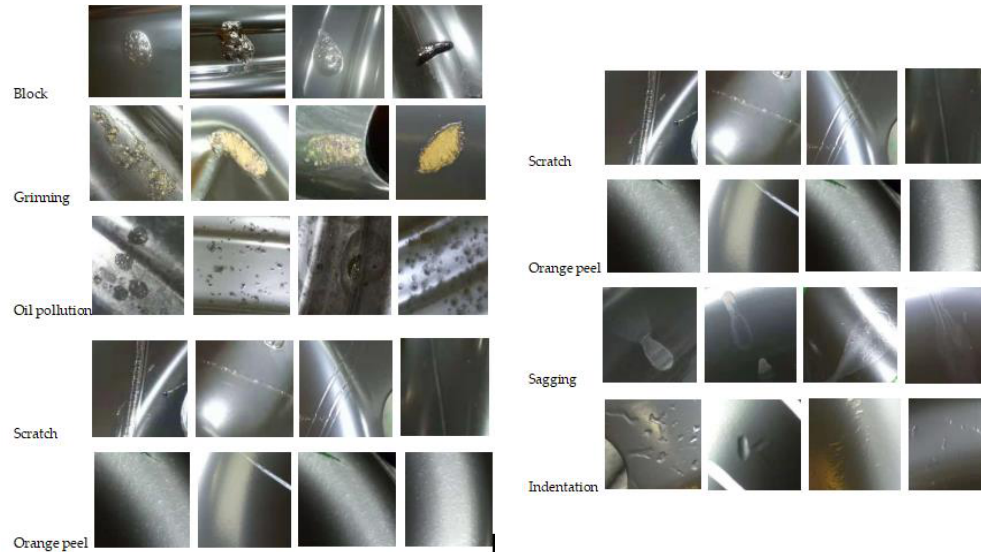
Figure 3. Images of wheel hub defects.